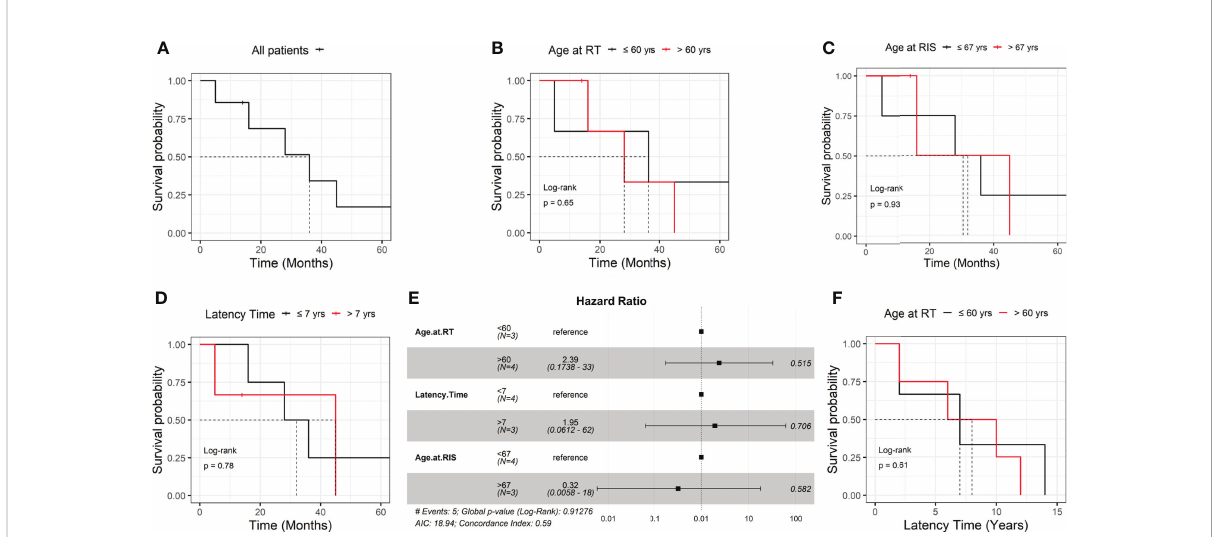
FIGURE 1 Association of radiation-induced sarcoma patients ’ overall survival with different parameters (A – E) . Association of radiation-induced sarcoma onset and age at radiation therapy (F) . RT, radiation therapy; RIS, radiation-induced